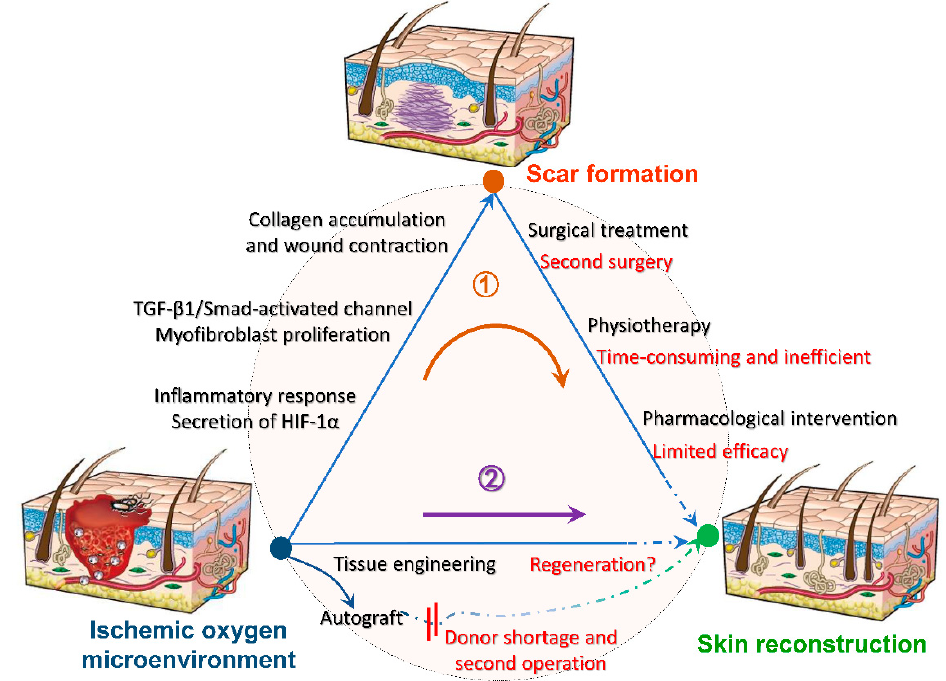
Figure 3. Mechanisms of oxygen-generating scaffolds to participate in trauma reconstruction. After hypoxia and anoxia of the damaged tissue, a series of reactions will contribute to scar formation, such as intense inflammatory response, conversion of fibroblasts to myofibers, excessive collagen deposition and wound contraction. Conventional treatments such as surgical excision are accompanied by limitations and incompleteness, making it difficult to heal the scar completely (route 1). Hence, we expect to intervene wound microenvironment by tissue engineering before scar formation to reduce or inhibit scar formation at the root (route 2). Reprinted with permission from [55]. Copyright (2008) Springer Nature.